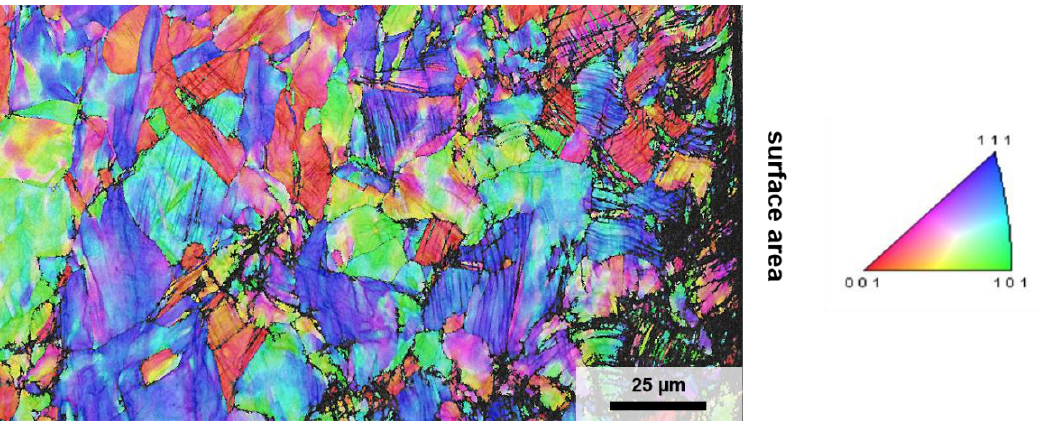
Figure 1. IPF map with superimposed IQ depicting the near-surface microstructure following deep rolling at 550 °C using a deep rolling force of 855 N. Color coding with respect to loading direction is in accordance with the standard triangle shown on the right.